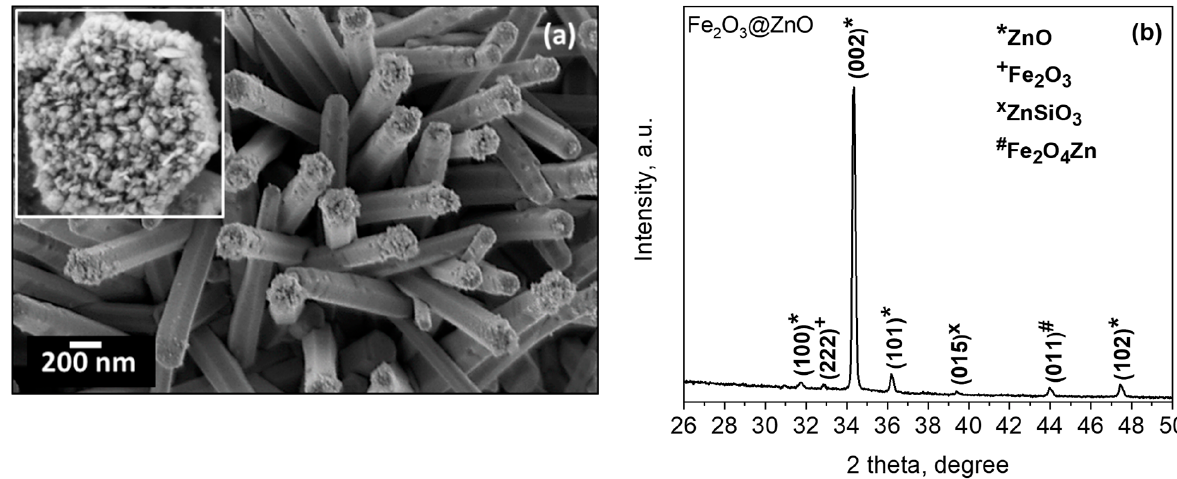
Figure 4. ( a ) SEM images (the inset shows a magnified image of the top of the Fe decorated ZnO rod) and ( b ) XRD diffraction pattern of the Fe 2 O 3 @ZnO structured film.